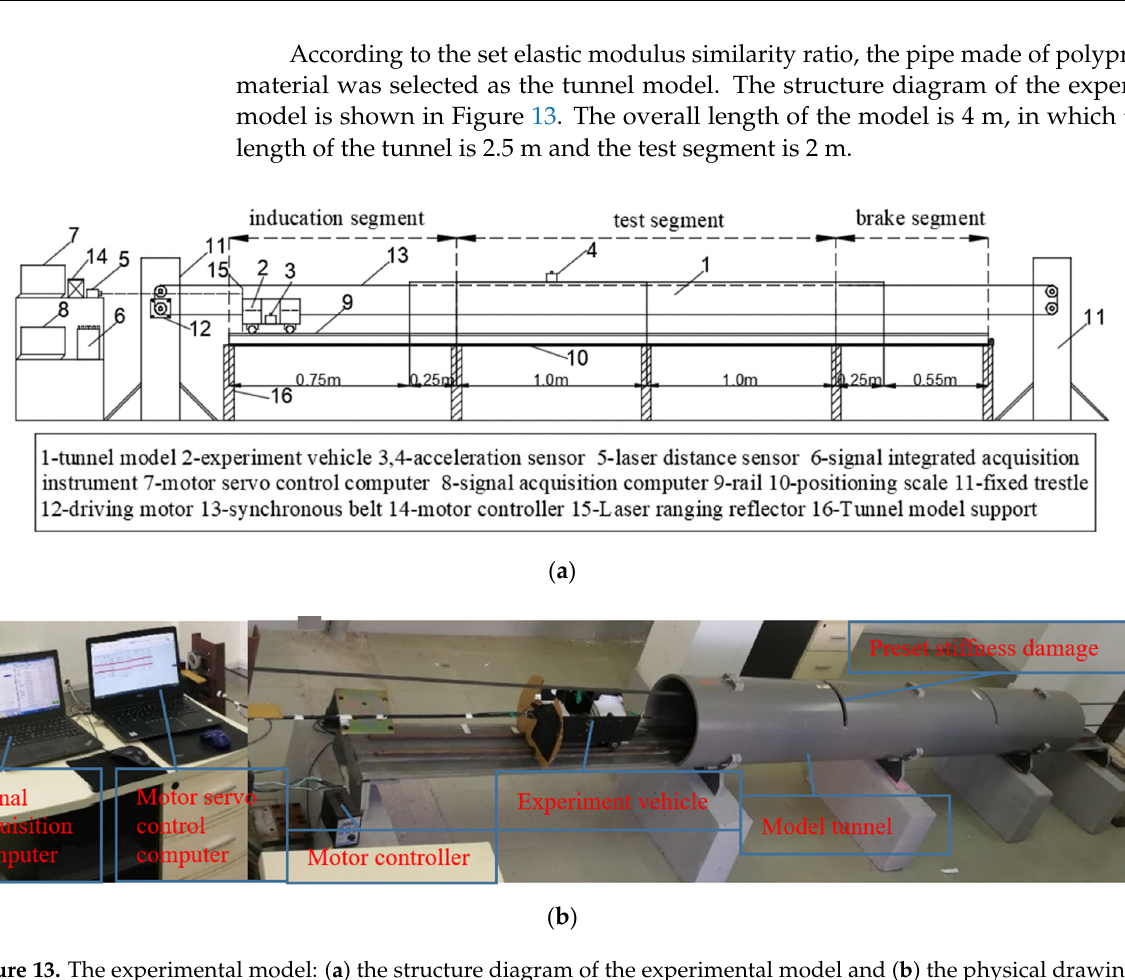
Figure 13. The experimental model: ( a ) the structure diagram of the experimental model and ( b ) the physical drawing of the experimental